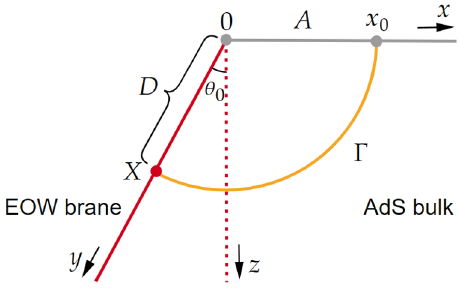
Figure 3 . The RT surface Γ for an interval A := [0 , x 0 ] that contains the boundary. When the boundary of the BCFT is contained in the interval, Γ will extend to the EOW brane, on which conformal matter is